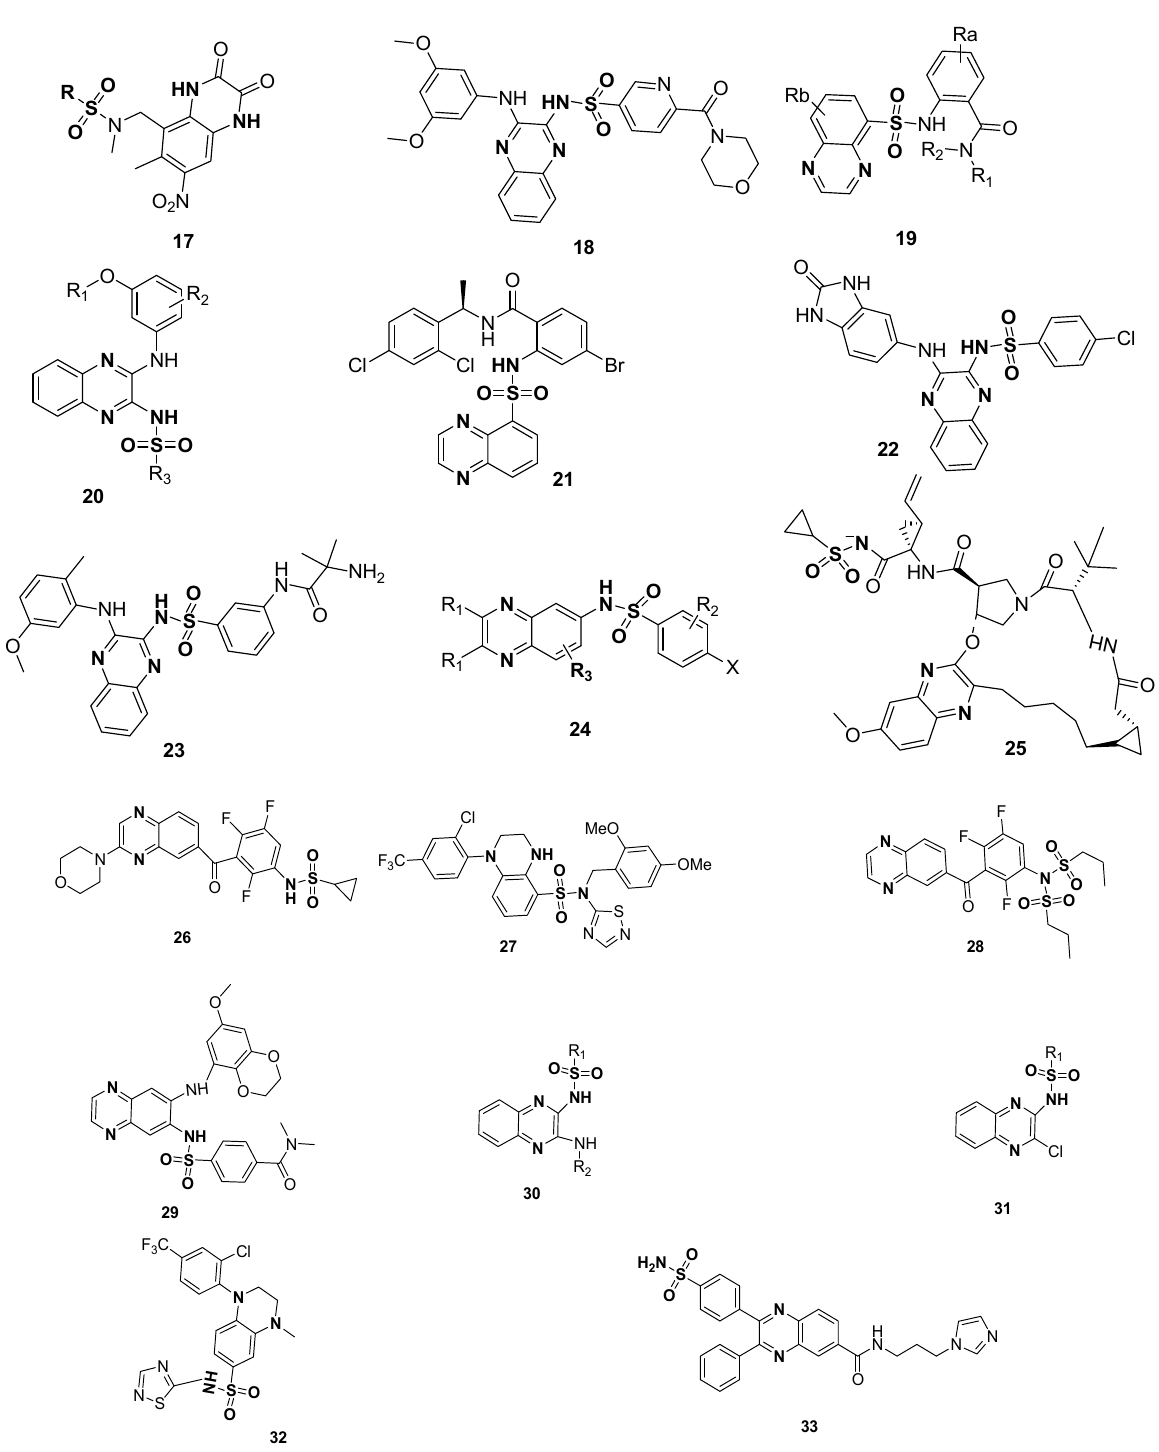
Figure 5. Structures of patented quinoxaline sulfonamides 17–33.